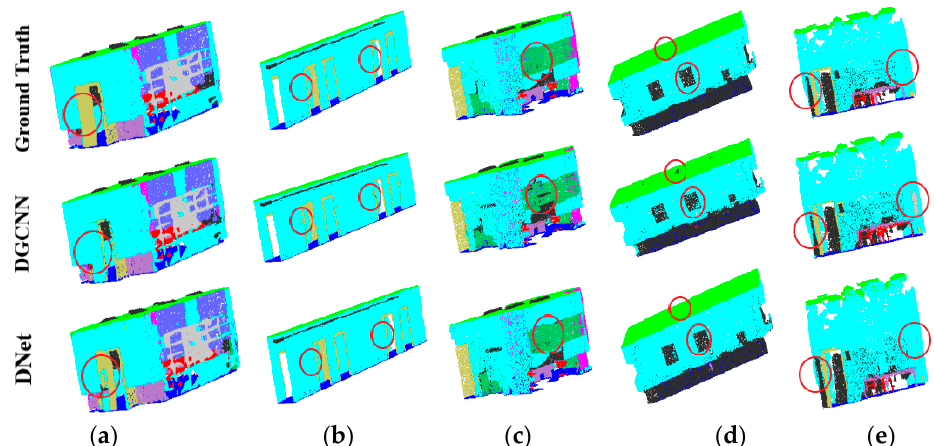
Figure 12. Comparison of point cloud segmentation with indoor scenes in the S3DIS dataset. ( a ) ConferenceRoom. ( b ) Hallway. ( c ) Office. ( d ) Pantry. ( e ) Storage.